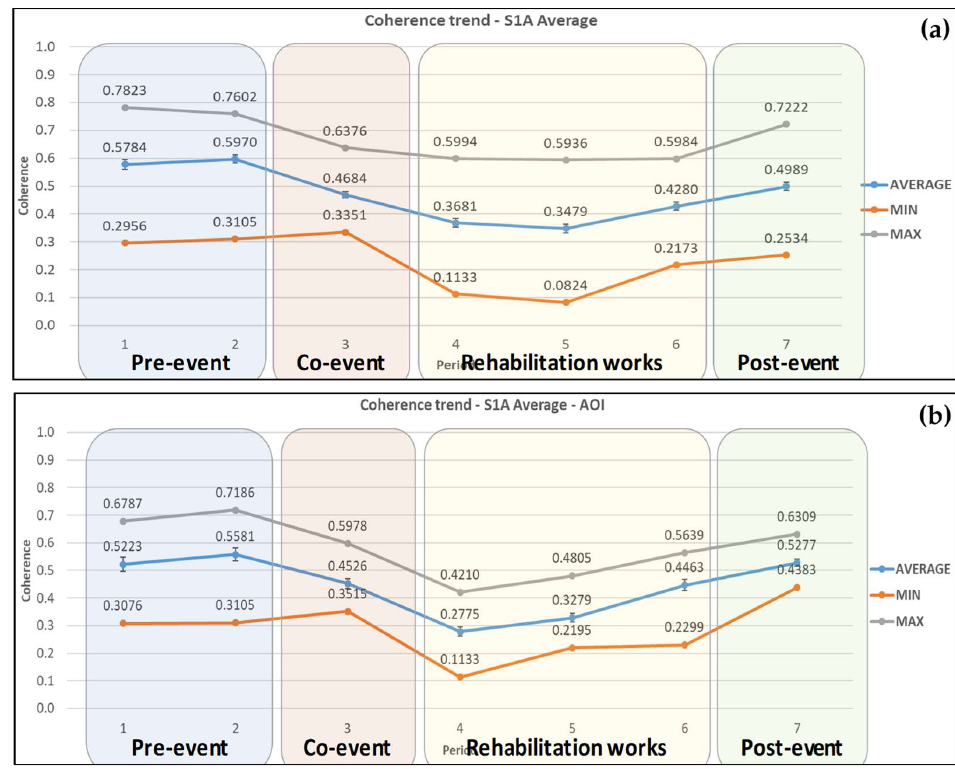
Figure 6. Average coherence changes obtained from Sentinel-1A ascending and descending satellite images for ( a ) the wider area and ( b ) the AOI. Error bars can be seen in the average coherence values.